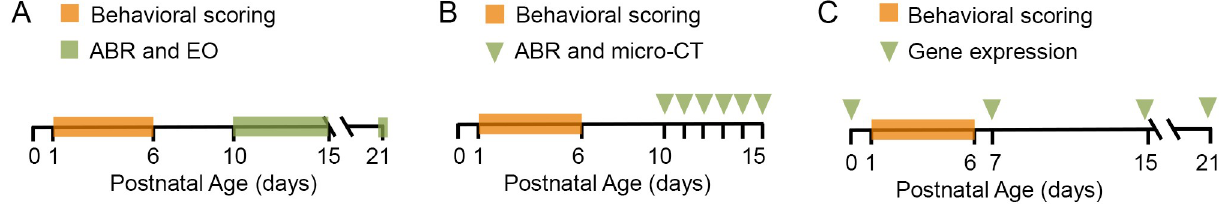
Fig 1. Experimental approach to test the hypothesis that maternal licking and grooming (LG) influences sensory neurodevelopment in Wistar rat pups. A , Developmental tracking experiments. After maternal behavior scoring and selection between P1 and P6, the auditory brainstem response (ABR) and eye opening (EO) were tracked daily in all pups from selected litters between P10 and P15, and at P21. B , Structure/function experiments. Following maternal behavioral scoring and selection between P1 and P6, correlative ABR and micro-CT X-ray (micro-CT) tomography measurements were obtained in pups from selected litters between P10 and P15 (indicated by arrow heads). C , Gene expression experiments. Pup brain samples were processed for mRNA extraction and gene expression screen at P0, P7, P15 and P21 (indicated by arrowheads).